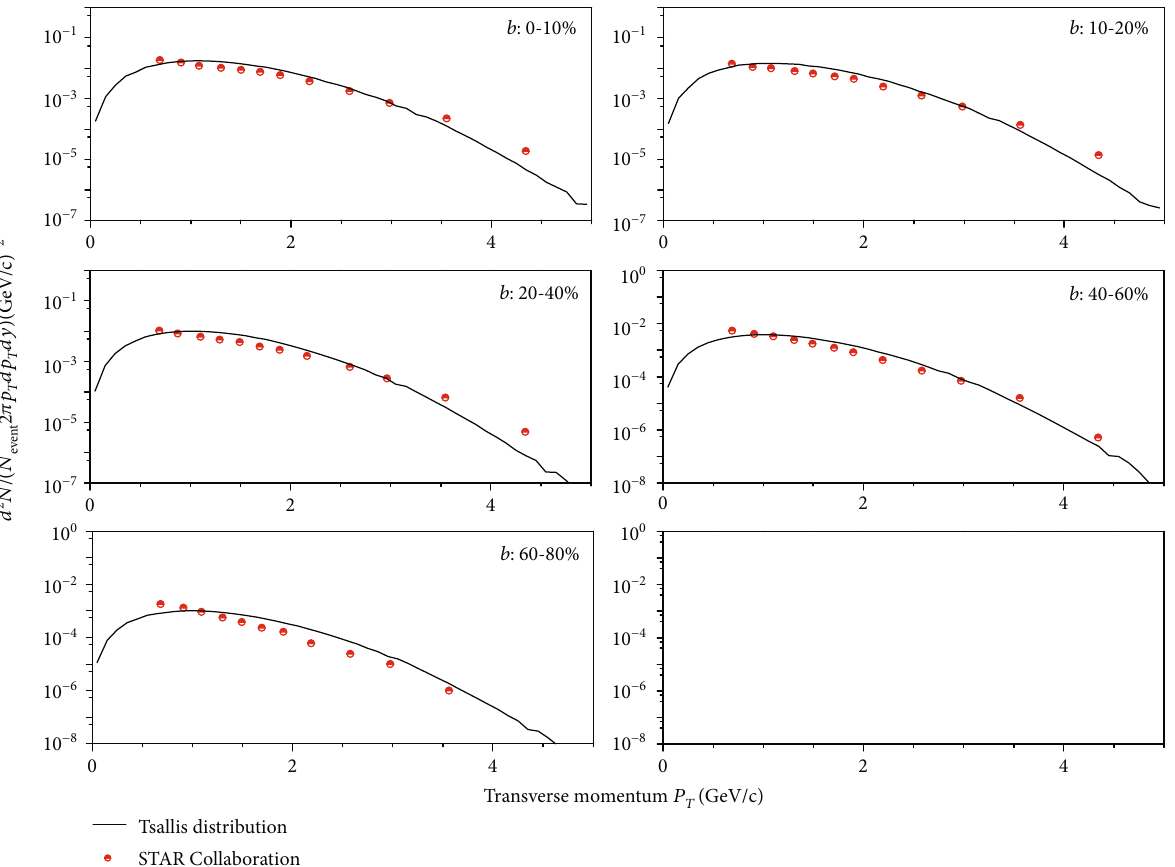
ffiffiffiffiffiffiffi p = 62 : 4 GeV for 0-10%, 10-20%, 20-40%, 40-60%, and 60- s NN